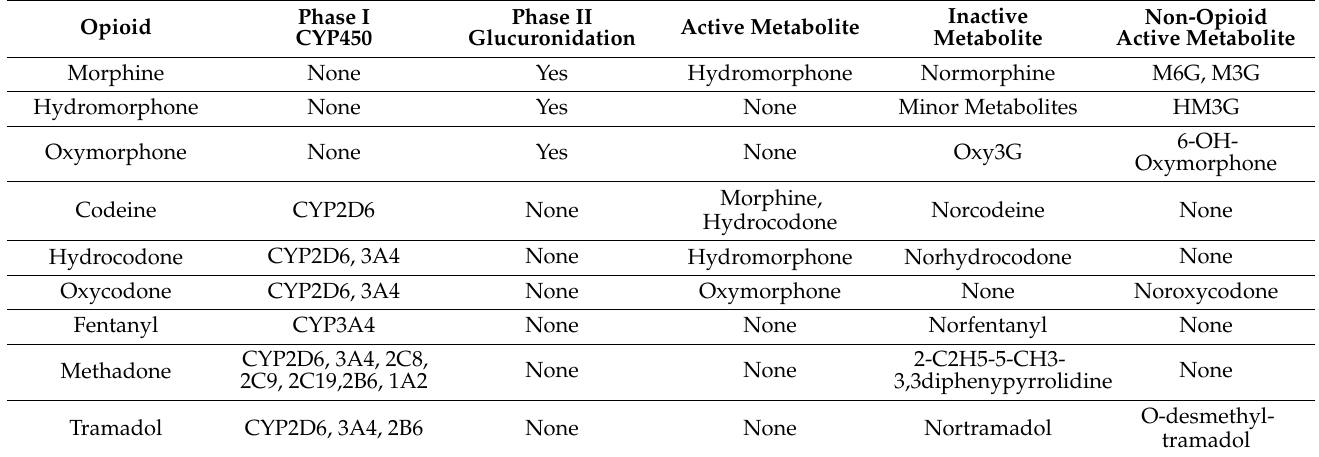
Table 4. Metabolic pathways of commonly used opioids in sickle cell